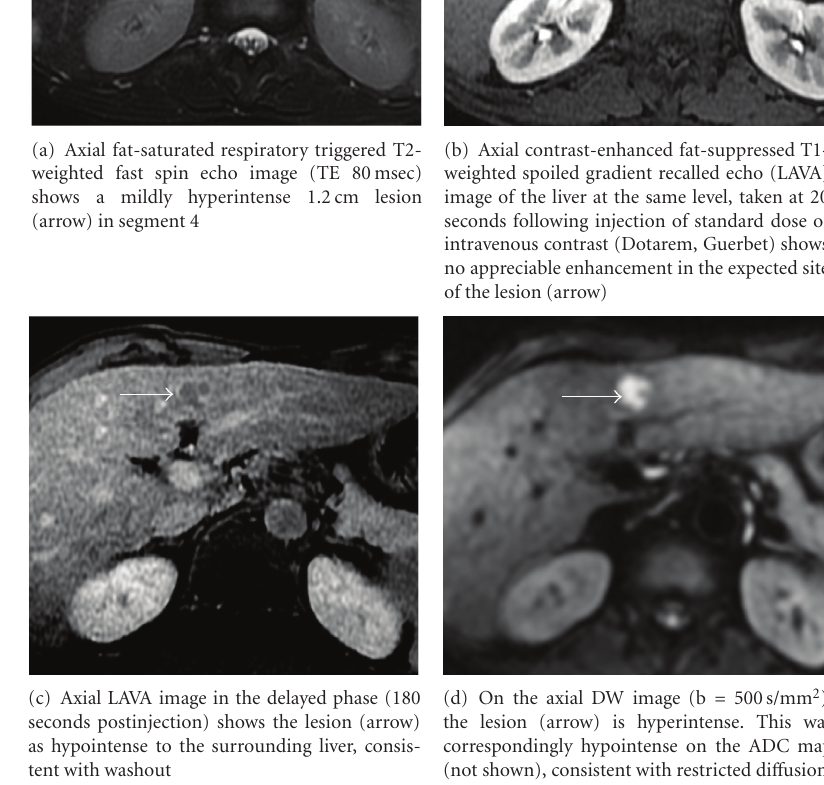
Figure 1: HIV positive patient with chronic HBV infection without known liver cirrhosis. By the AASLD and APASL guidelines, this lesion would require further evaluation. CT done prior to the MRI also failed to demonstrate arterial hypervascularity. Note, however, that the lesion showed suspicious features on T2-weighted and DW imaging. The lesion was biopsied percutaneously under ultrasound guidance and showed to represent a well-di ff erentiated